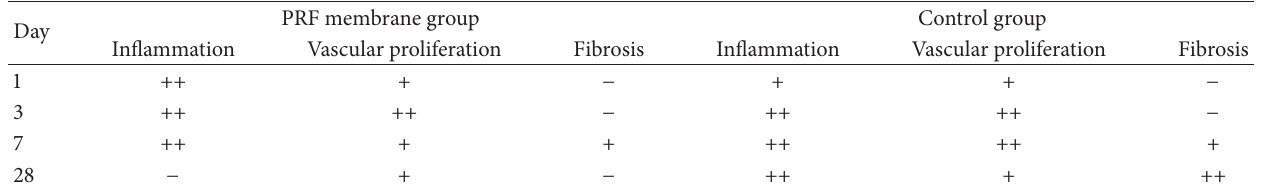
Figure 4: (a) Almost all of the defective zone reepithelialized on day 7 in the PRF membrane group. PRF membrane was integrated with the surrounding conjunctiva (arrow). (b) Conjunctival healing was completed on day 28 in the PRF membrane group without any complications. (c) The conjunctival defect (arrow) was persistent with mild hemorrhage on day 28 in the control group. Table 1: The comparison of hematoxylin and eosin